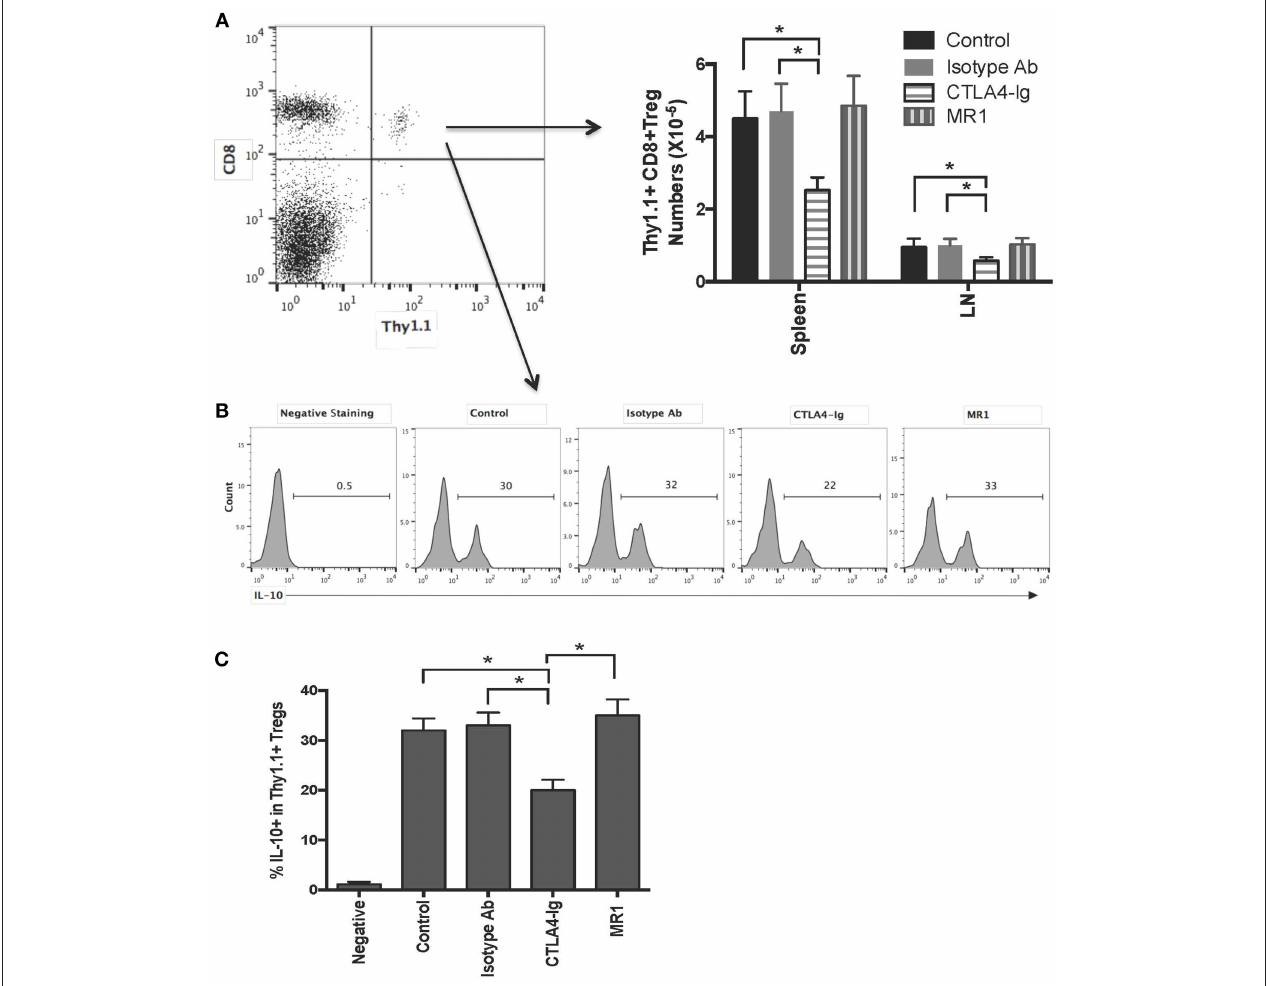
FIGURE 4 | Costimulatory blockade of B7/CD28, but not CD40/CD154, reduces numbers of transferred CD8 + CD122 + PD-1 + Tregs and frequency of IL-10-expressing Tregs in recipient mice. C57BL/6 mice received CD8 + CD122 + PD-1 + Tregs derived from Thy1.1 + mice (C57BL/6 background). They were then transplanted with BALB/c skin and treated with either MR1 or CTLA4-Ig. Two weeks later, transferred CD8 + Thy1.1 + Tregs were quantified via FACS analysis (A) or stained for intracellular expression of IL-10. Histograms showing percentages of IL-10 + cells were gated on transferred CD8 + Thy1.1 + population with one representing set of FACS data (B) . Data are presented as mean ± SD from one representative of three separate experiments (C) . * P <